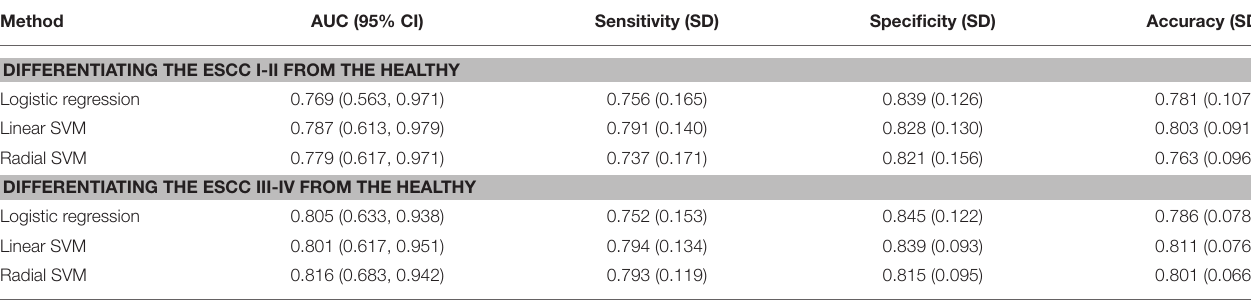
TABLE 5 | Diagnostic performance in differentiating ESCC subgroups from the healthy for the three-miRNA-based classifiers. Method